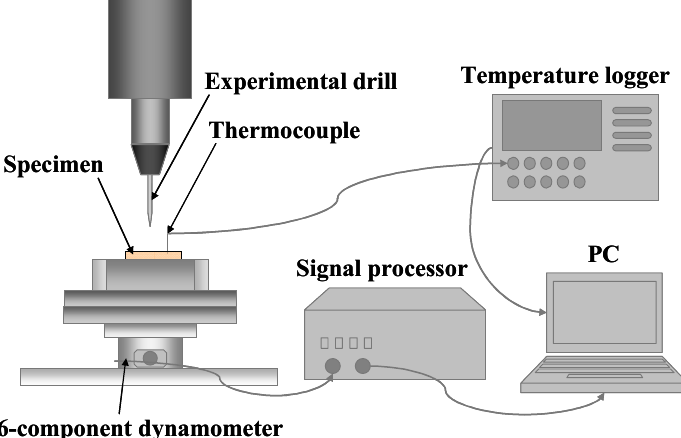
Fig. 3 Experimental setup used for the drilling